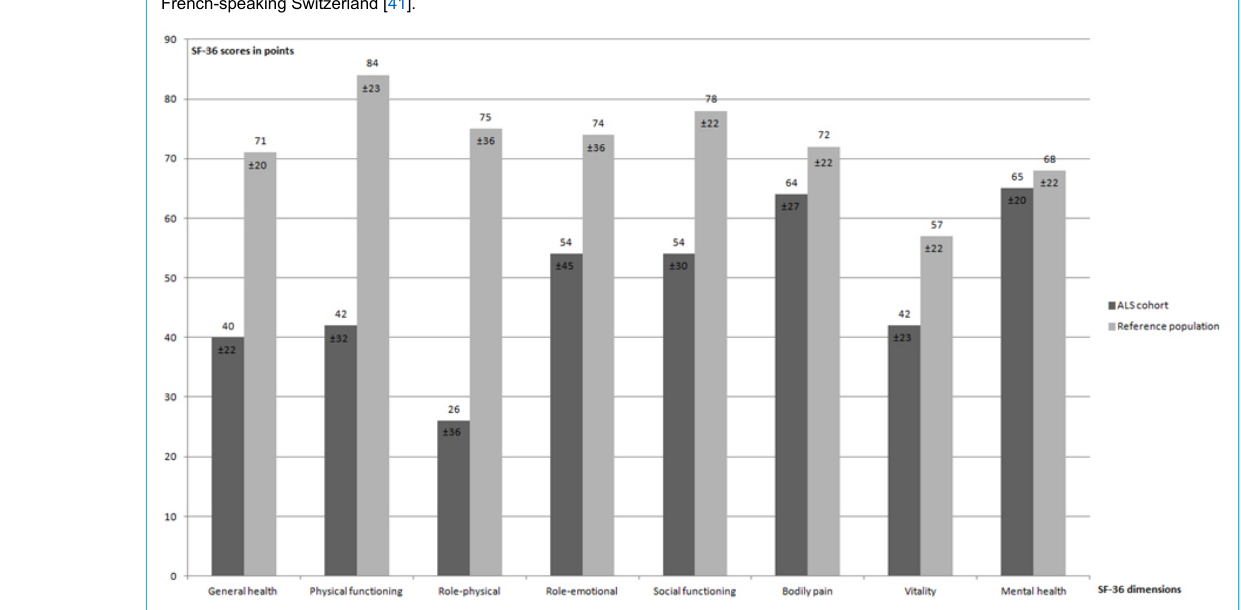
Figure 5: Comparison of SF-36 values (mean ± SD) in our ALS cohort at inclusion with a reference population of healthy individuals in French-speaking Switzerland